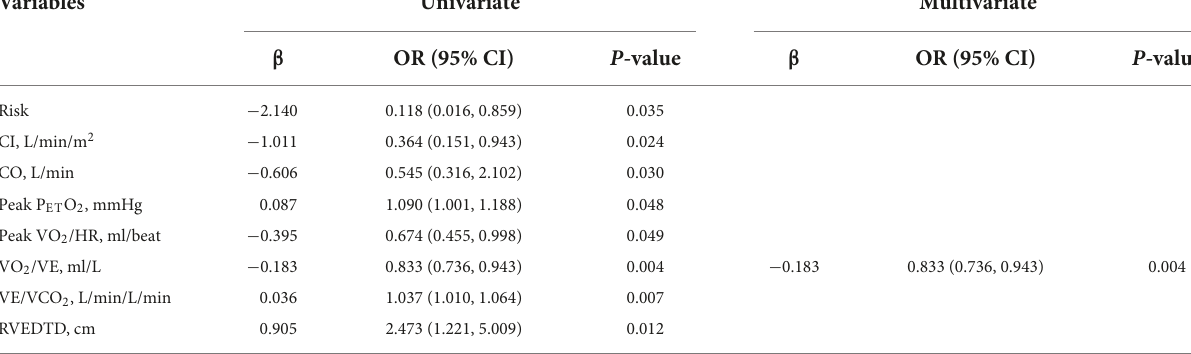
TABLE 3 Binary logistic regression analysis of factors correlated with EIS in IPAH patients. Variables Univariate Multivariate